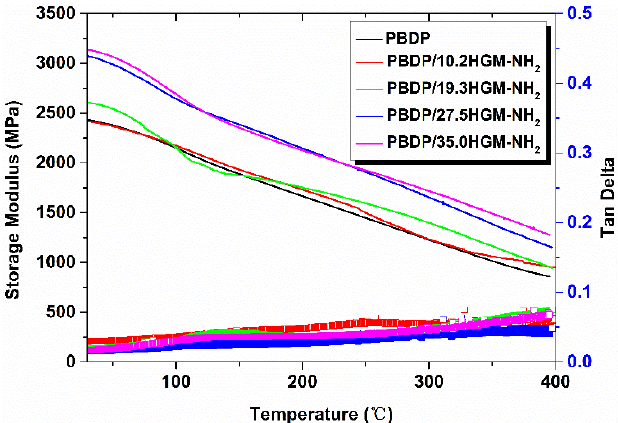
Figure 8. DMA curves of the neat PBDP, PBDP/HGM-NH 2 composites.